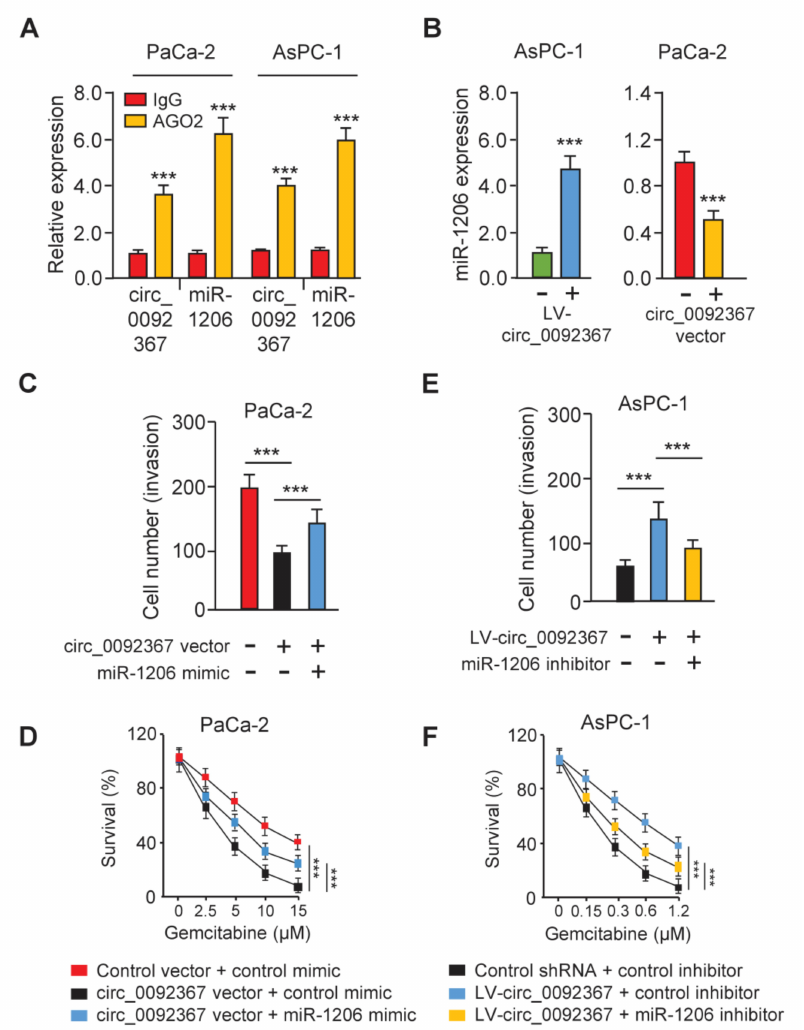
Figure 5. Circ_0092367 Sponges MiR-1206 in PC Cells. ( A ) RIP assay was used to quantify the expression of circ_0092367 and miR-1206 in PC cells. ( B ) miR-1206 expression in PC cells was tested after either overexpression or knockdown of circ_0092367. ( C , D ) Decreased cell invasion ( C ) and gemcitabine resistance ( D ) in circ_0092367-overexpressed cells were rescued by miR-1206 mimic. ( E , F ) However, increased cell invasion ( E ) and gemcitabine resistance ( F ) in circ_0092367-knockdown cells were reversed by miR-1206 inhibitor. The experiments in ( A – F ) were repeated three times independently with similar results. *** p